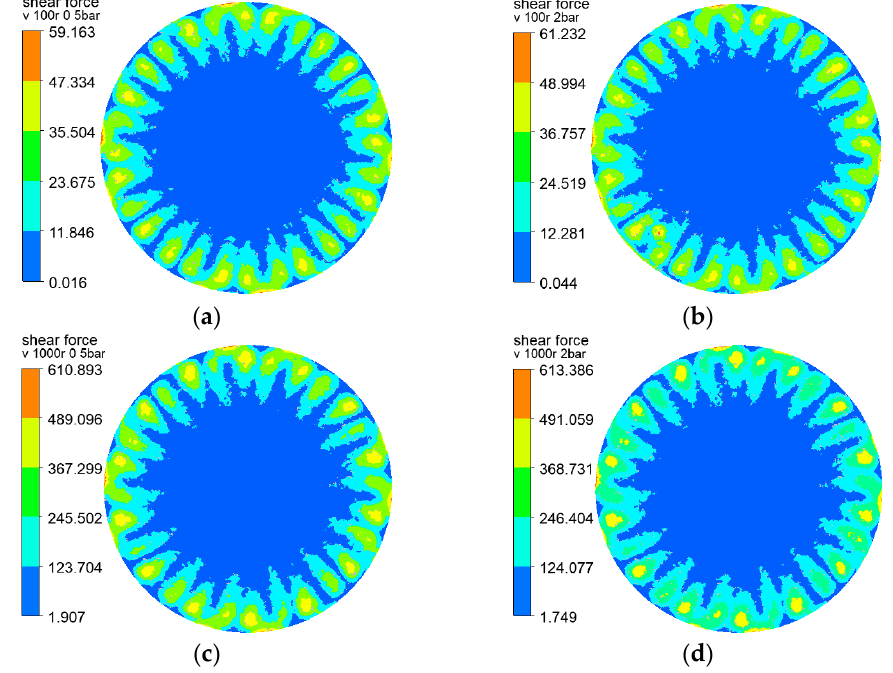
Figure 4. Cloud charts of shear force on the membrane surface when the vane is at different rotating speeds and pressures: ( a ) r = 100 r/min, △ P = 0.5 bar ( b ) r = 100 r/min, △ P = 2 bar ( c ) r = 1000 r/min, △ P = 0.5 bar ( d ) r = 1000 r/min, △ P = 2 bar.